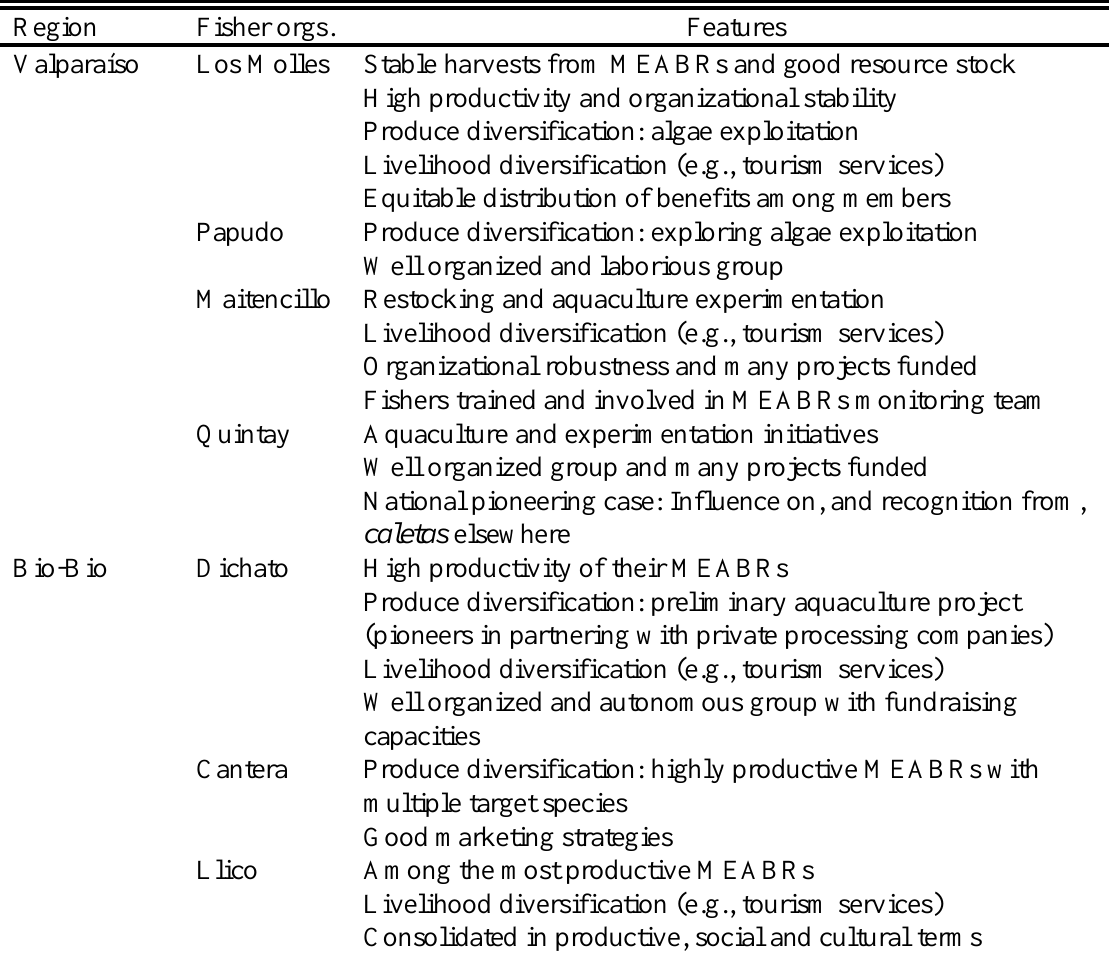
APPENDIX 3: Features of “star caletas ” in the MEABRs co-management system, as reported by multiple informants from the small-scale fishery, public, private and academic